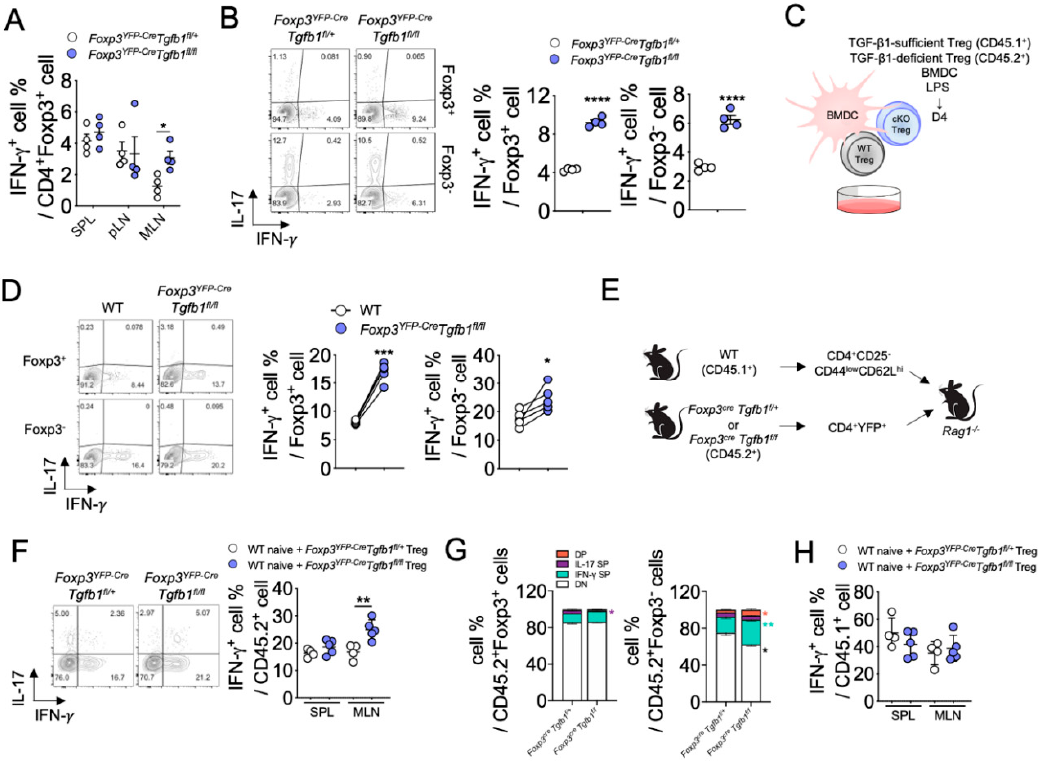
Figure 3. TGF- β 1 deficiency intrinsically promotes the conversion of Treg cells into IFN- γ -producing cells. ( A ) Quantification of IFN- γ -expressing cells within CD4 + cells from SPL, pLN, and MLN ( n = 4). ( B ) Purified Treg cells co-cultured with bone marrow-derived dendritic cells (BMDC) in the presence of LPS. Representative contour plots of IFN- γ - and IL-17A-expressing cells within CD4 + Foxp3 + or CD4 + Foxp3 − cells. Quantification of IFN- γ -expressing cells among CD4 + Foxp3 + or CD4 + Foxp3 − cells. ( C , D ) Mixed-Treg cell co-culture experiment. ( C ) Schematic representation of mixed-Treg cell co-culture experiment. ( D ) Flow cytometric analysis of IFN- γ and IL-17 expression in CD45.1 + (wild-type (WT); TGF- β 1-sufficient) or CD45.2 + (conditional knockout (cKO); TGF- β 1-deficient) cells. ( E ) Schematic representation of Treg cell adoptive co-transfer experiment. WT naïve T cells (CD45.1 + ) were transferred to Rag1 − / − mice with sorted YFP + Tregs cells from Foxp3 YFP-Cre Tgfb1 fl/+ or Foxp3 YFP-Cre Tgfb1 fl/fl mice ( n = 4–5). ( F ) Flow cytometry plots of IFN- γ and IL-17 expression in MLN of CD45.2 + cells and quantification of IFN- γ + cells among CD45.2 + cells in SPL and MLN ( n = 4–5). ( G ) Proportion of IFN- γ - or IL-17-producing cells among Foxp3 − CD45.2 + or Foxp3 + CD45.2 + cells in MLN ( n = 4–5). ( H ) Quantification of IFN- γ + cells among CD45.1 + cells in SPL and MLN ( n = 4–5). Data are representative of four ( A ), five ( B ), or two ( C – H ) independent experiments. Quantification plots show mean ± SD ( A , B , F , H ). * p ≤ 0.05, ** p ≤ 0.01, *** p ≤ 0.001, and **** p ≤ 0.0001 based on two-tailed Student’s t -test.